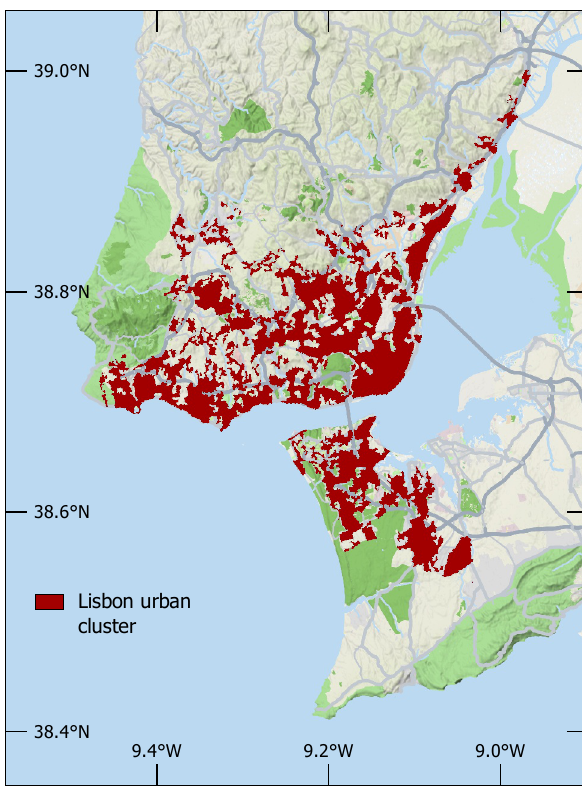
Figure 4. The Lisbon urban cluster supplied by B. Zhou (see Zhou et al., 2013). The red-shaded area represents continuous and discon- tinuous urban fabric as classified in the CORINE land cover data (Büttner et al., 2007).